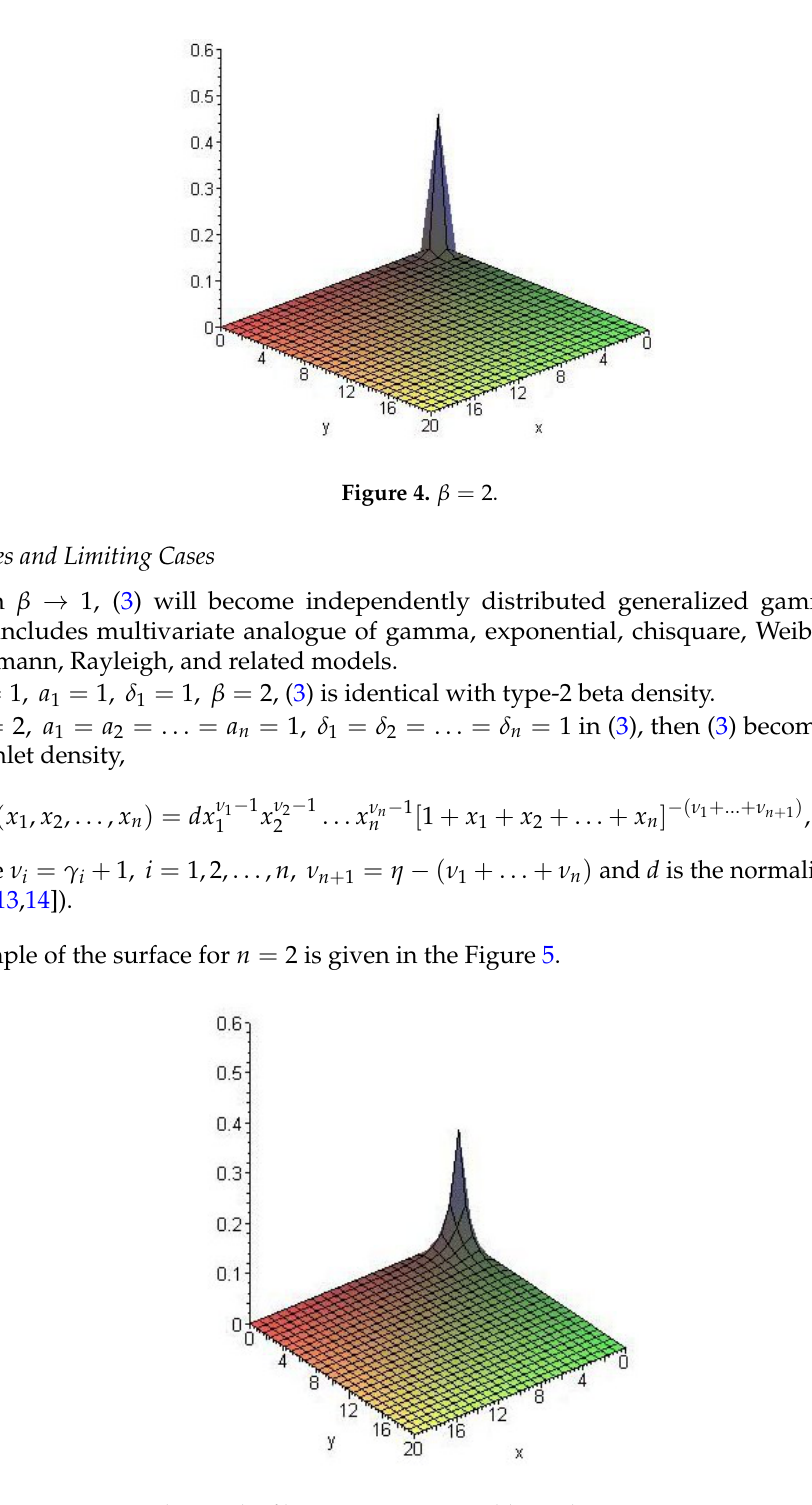
Figure 5. The graph of bivariate type-2 Dirichlet with γ 1 = γ 2 = 1, η =